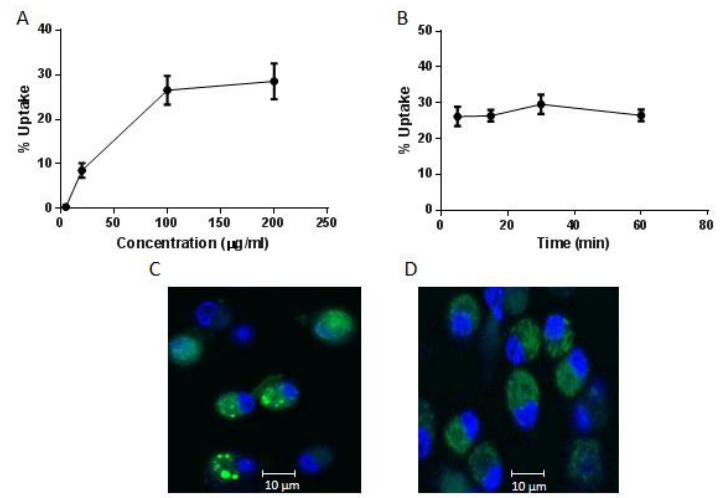
Figure 2. Uptake of AntpMAPMUC1tet peptide by dendritic cells (DC) in vitro. ( A ) DC were pulsed with AntpMAPMUC1tet peptide at either varying concentrations (5 to 200 µ g/mL) for 60 min or ( B ) a constant dose of 100 µ g/mL for set times between 5 and 60 min. Uptake was determined by flow cytometry as the percent surface staining subtracted from the percent intracellular staining (mean ± SEM, for 3 replicates). ( C ) DCs were incubated with 100 µ g/mL Alexa-labelled AntpMAPMUC1tet (green) in chamber slides for 2 h, counterstained with Hoechst nuclear stain (blue), washed and visualized by confocal microscopy or ( D ) DC were pre-treated with 10 µ g/mL cytochalasin D before AntpMAPMUC1tet pulsing. Moderate uptake of AntpMAPMUC1tet is seen at 20 µ g/mL, with maximum uptake at 100 µ g/mL and plateau at 200 µ g/mL. To investigate kinetics of uptake DC were incubated at various times with AntpMAPMUC1tet (5–60 min) at a fixed concentration (100 µ g/mL) and internalisation